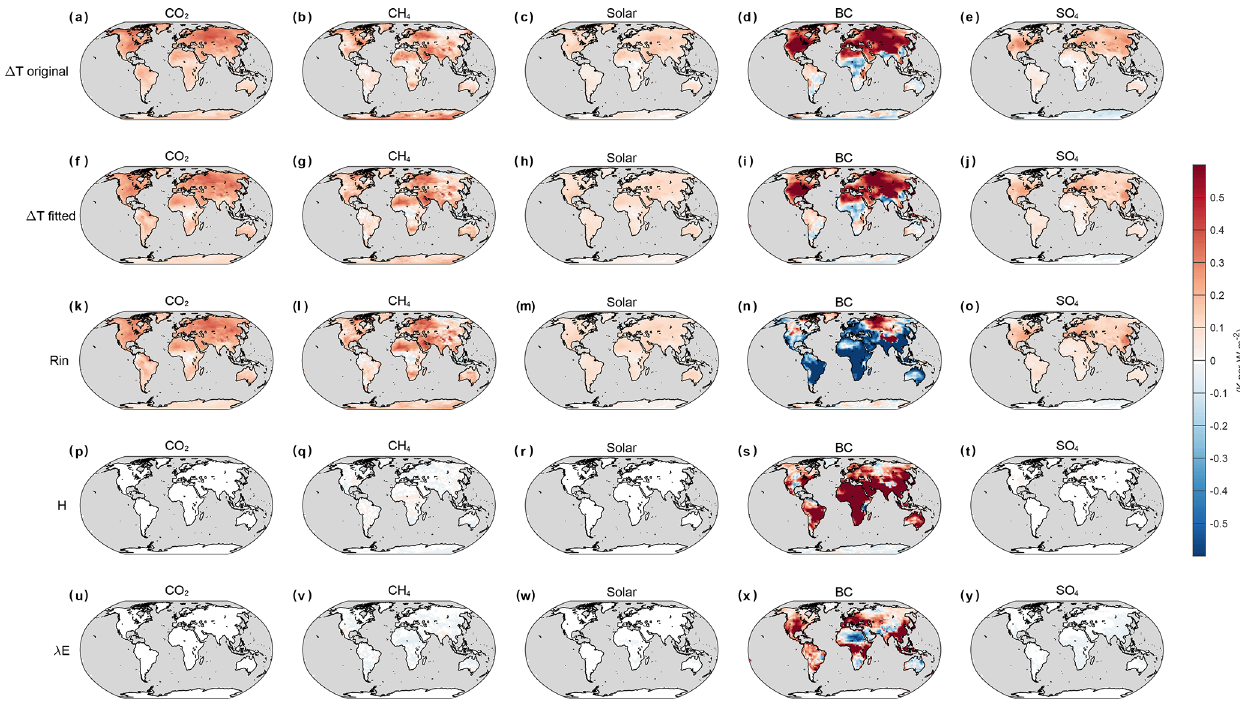
Figure 5. Air temperature change per unit of forcing. Original (cid:49)T (a–e) , (cid:49)T estimated from multi-linear regression model (f–j) , and temperature change contributed by each component based on the linear regression models (k–y) . Table 3. Multi-linear regression model for each